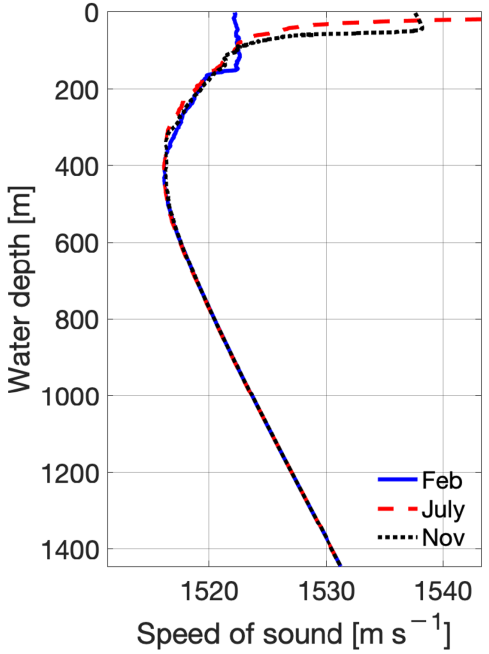
Figure 2. Typical sound-speed profiles for the study area, which were calculated by the equation of Chen and Millero [55] from CTD measurements made near the study are in 2018 [54]. These July and November sound-speed profiles were used as the summer- and winter-velocity profiles, respectively, in the top layer of our model.